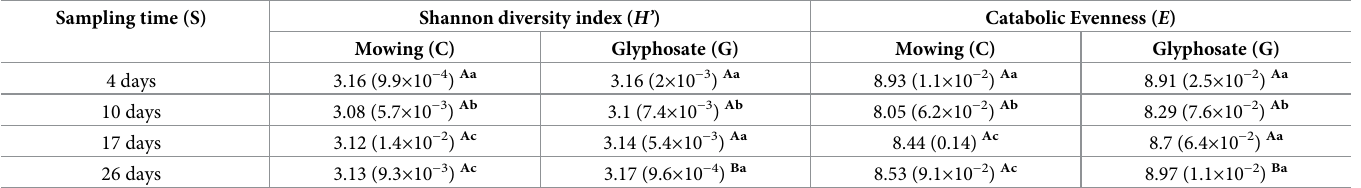
Table 2. Catabolic diversity of microbial communities. Evenness ( E ) and Shannon index ( H’ ) values are indicated for each treatment. Values between brackets indicate the standard error of the mean (n = 4). Upper case letters indicate statistically significant differences between suppression methods at each sampling time. Lower case letters indicate statistically significant differences among sampling times within a suppression method ( P < 0.05, Tukey’s HSD test). Sampling time